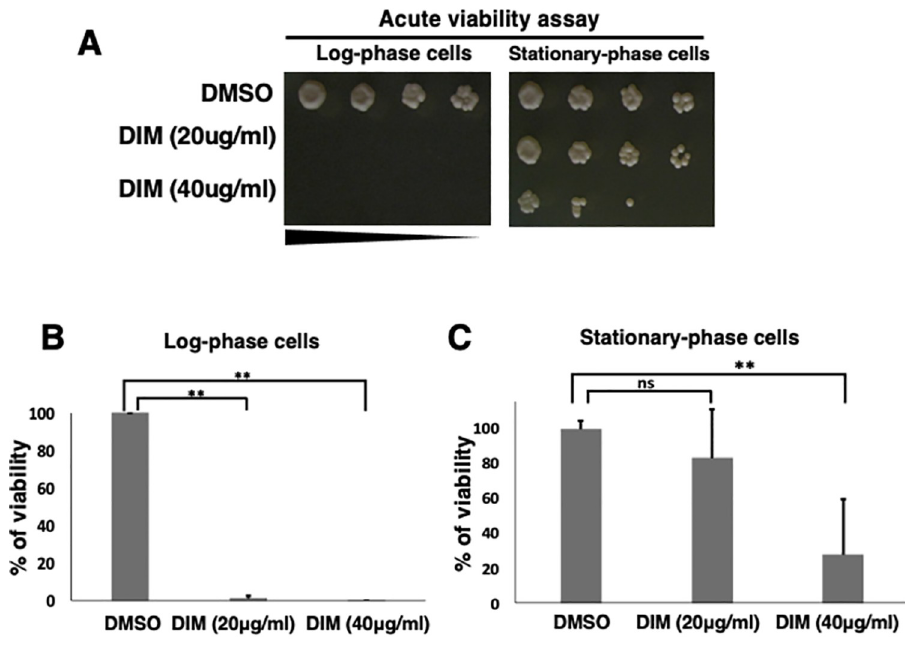
Fig 2. 10 minutes incubation with DIM is enough to kill log-phase cells. (A) To perform the acute viability assay, the same concentration of log-phase cells and stationary-phase cells (1 x 10 7 cells/ml) were incubated in the presence of 3,3’-Diindolylmethane (DIM) or DMSO for 10 minutes. Treated cultures were spotted and incubated at 30˚C for 3 to 5 days to capture images. (B and C) The percentages of viability for treated cells as in A are shown. See materials and methods for